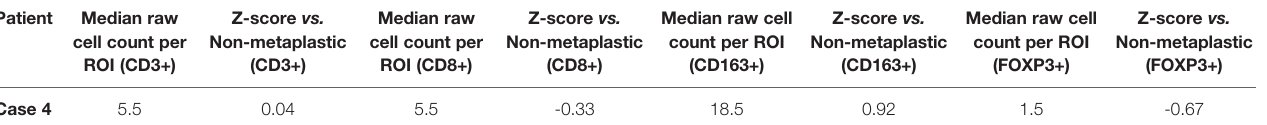
TABLE 2 | Immune cell counts in Case 3 by mIF.